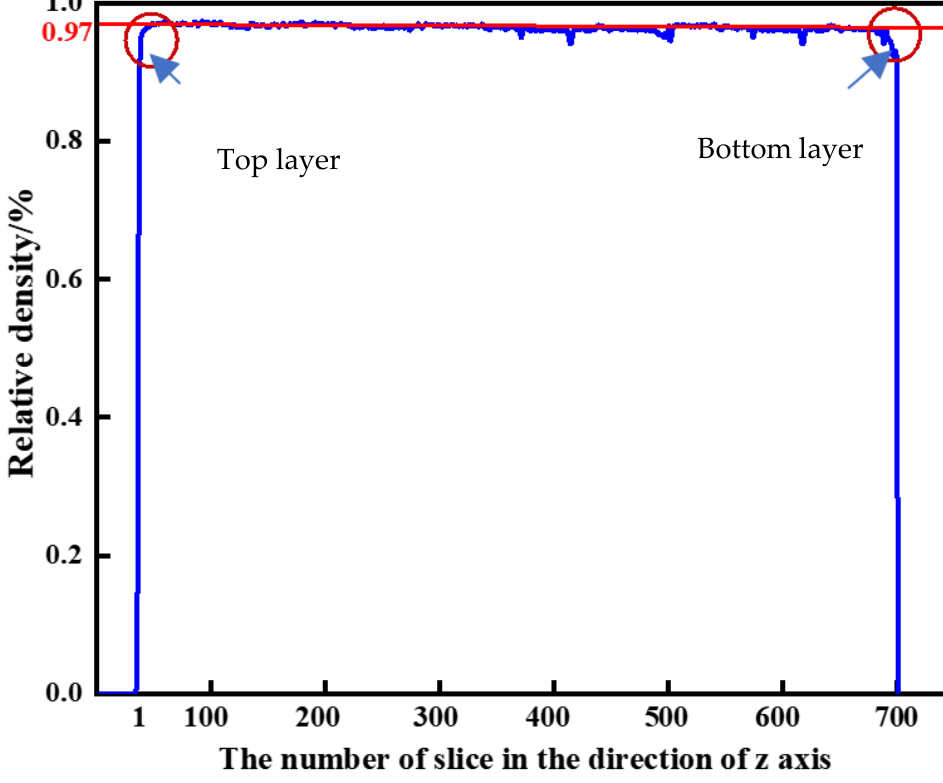
Figure 12. Density of sample 2 along Z-axis.